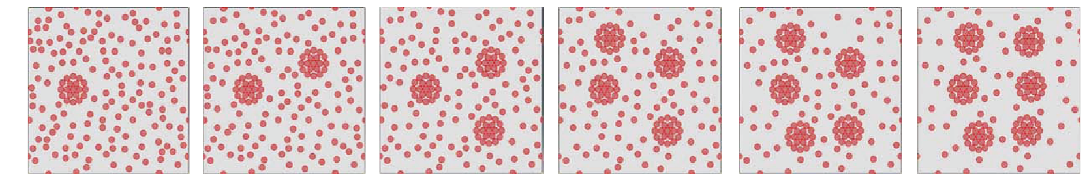
Figure 13: Di ff erent carbon cluster numbers in same particle size models. Table 6: Grid numbers of di ff erent cluster models.